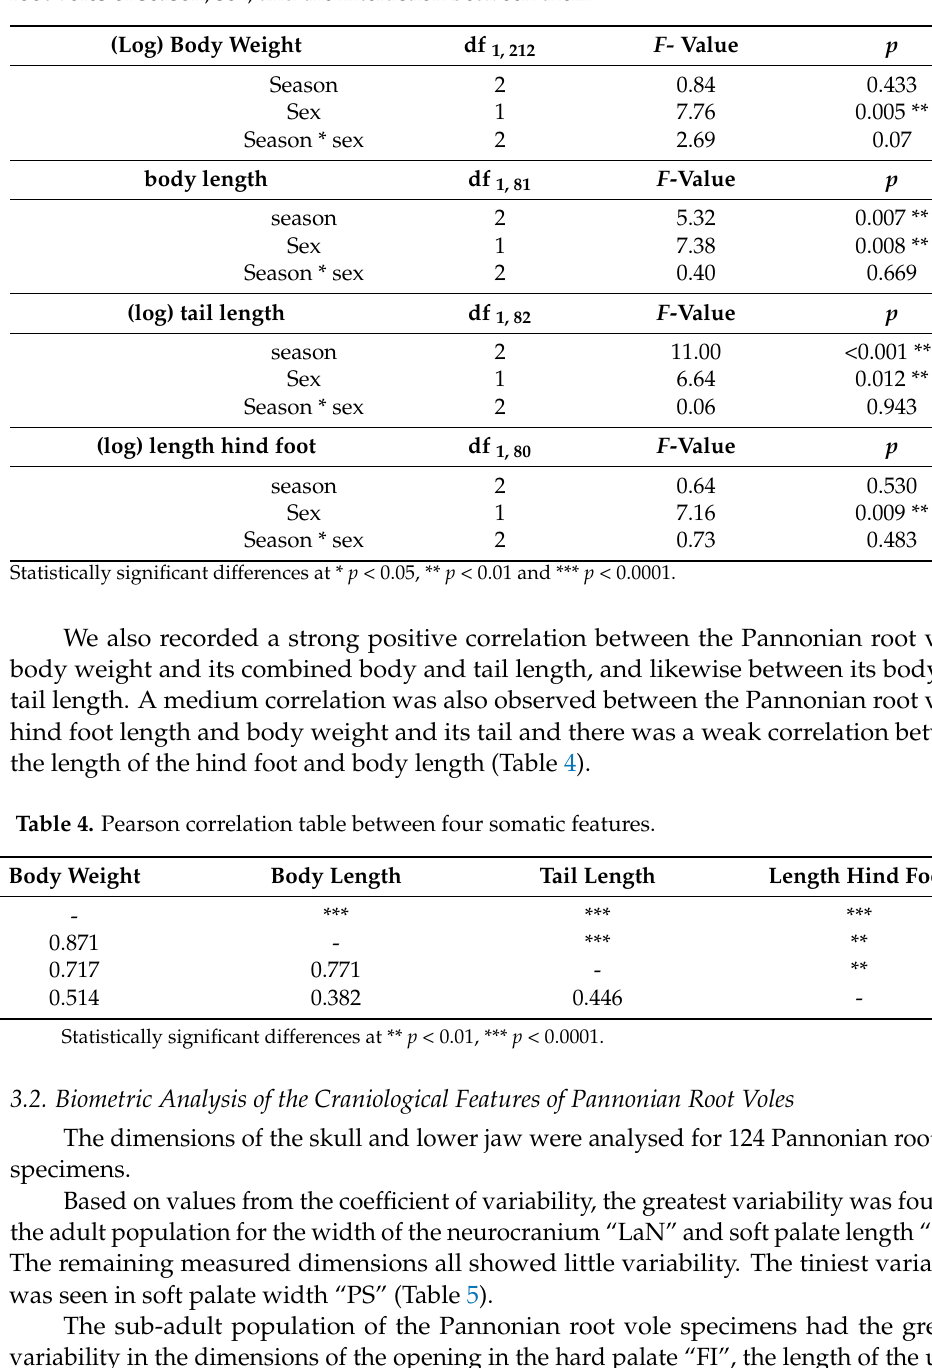
Table 3. Two-way ANOVA analysis of the impact on four somatic characteristics of adult Pannonian root voles of season, sex, and the interaction between them.